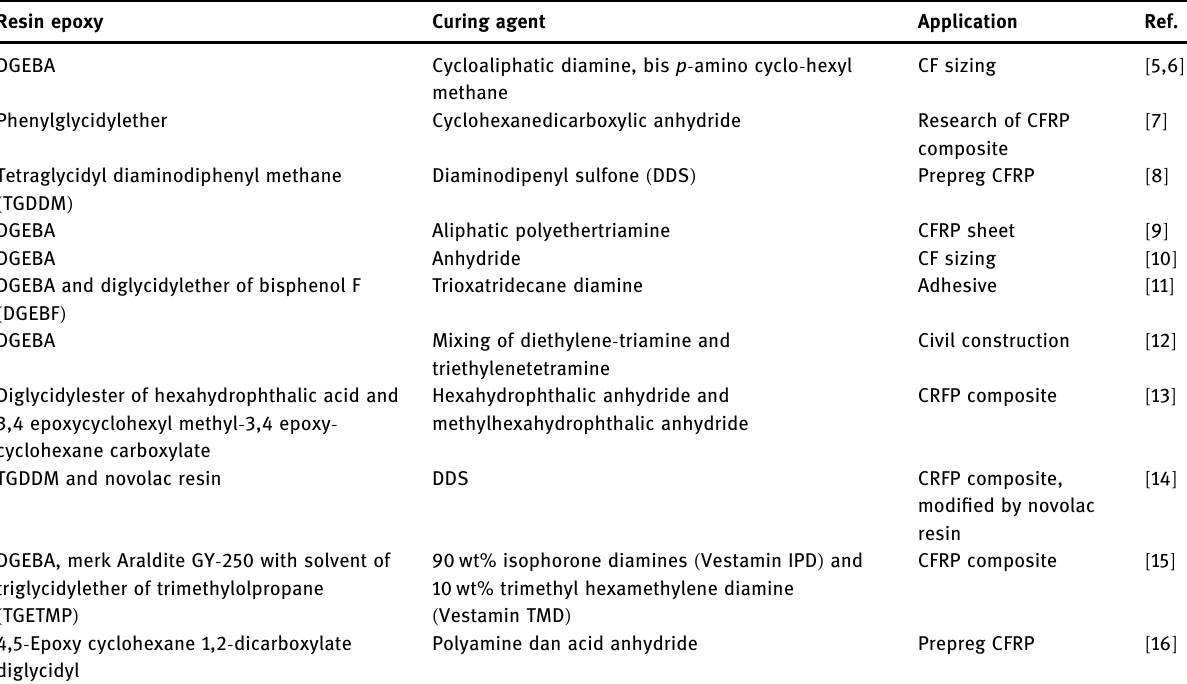
Table 1: The epoxy resins and curing agents commonly used in researches and productions Resin